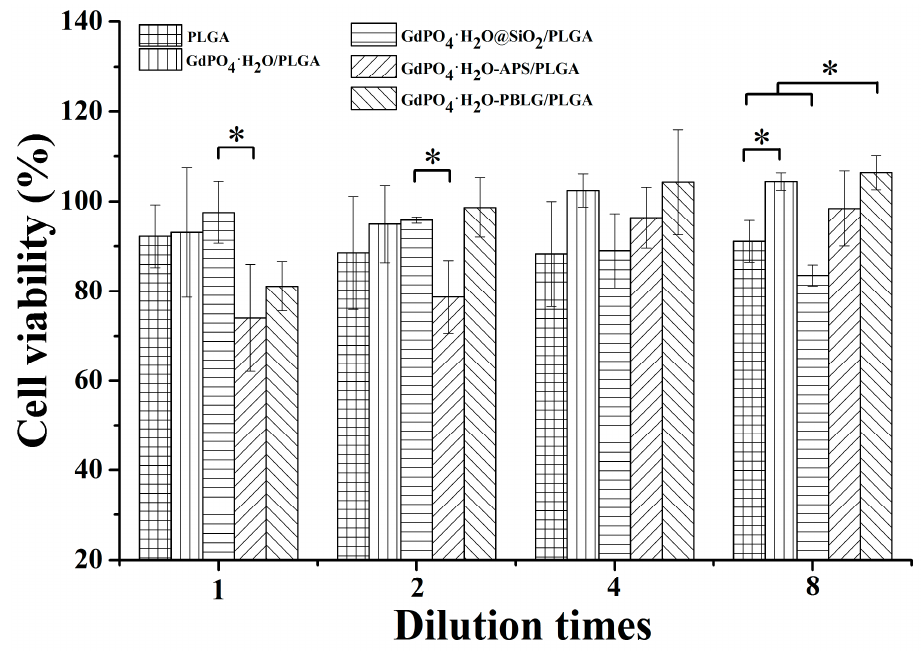
Figure 10. Cytotoxicity histogram of leaching liquid for PLGA, GdPO 4 · H 2 O/PLGA, GdPO 4 · H 2 O@SiO 2 /